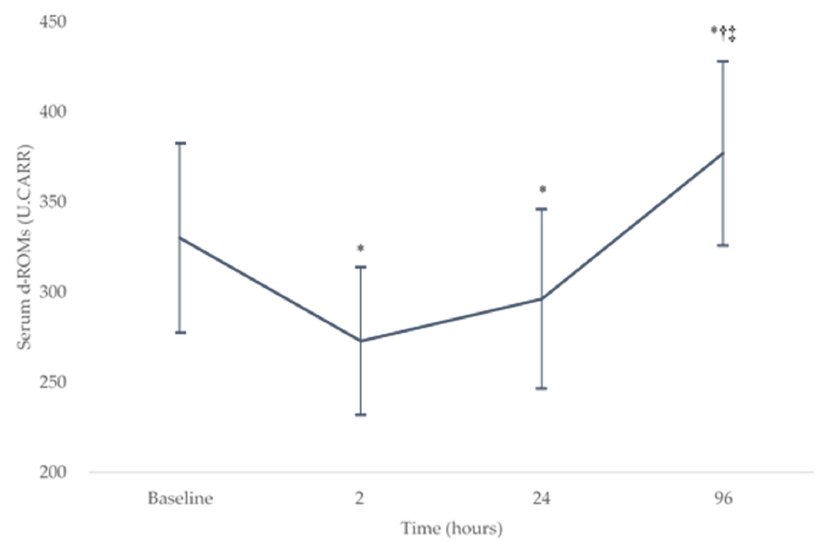
Figure 1. Changes in the serum d-ROMs levels over the baseline and postoperative testing sessions. * p < 0.008 compared with the baseline level, † p < 0.008 compared with the level at 2 h after surgery,